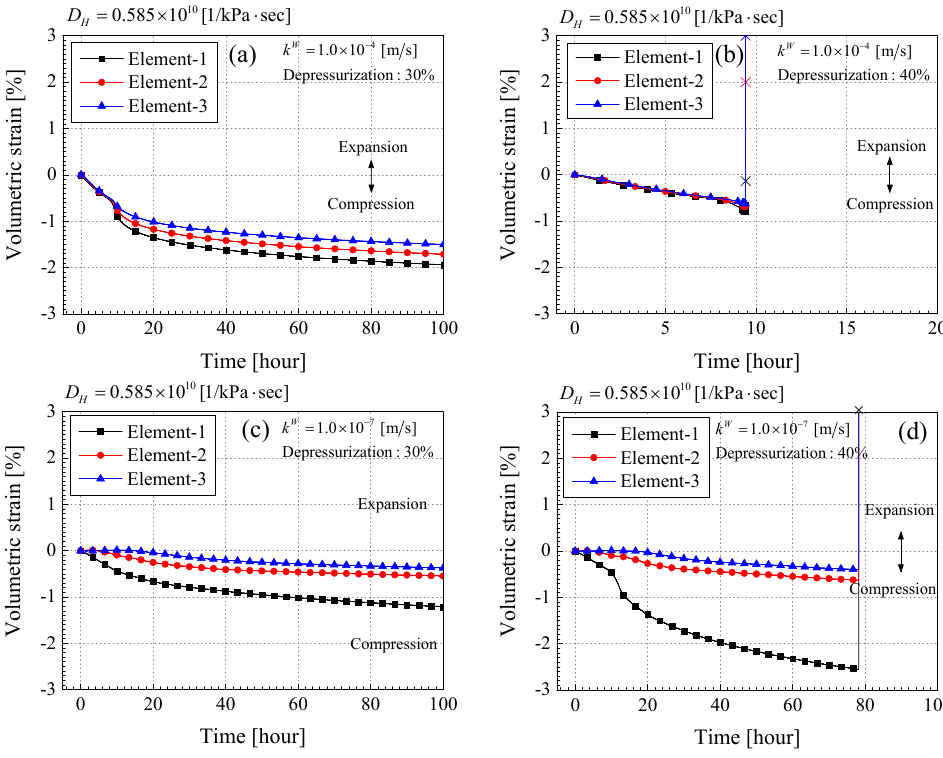
(%). ( a ) Case-4-30; ( b ) Case-4-40; v